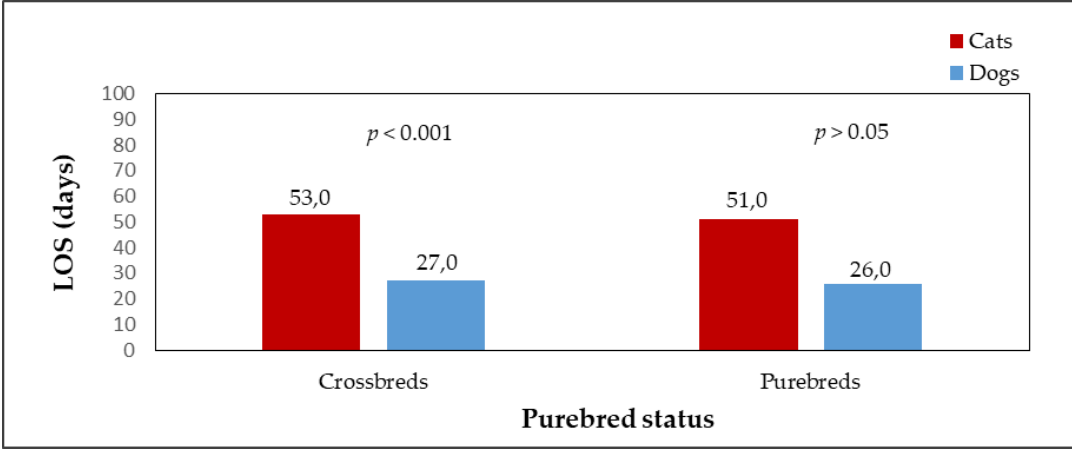
Figure 6. The median LOS of dogs (n = 1071) and cats (n = 367) as affected by purebred status.